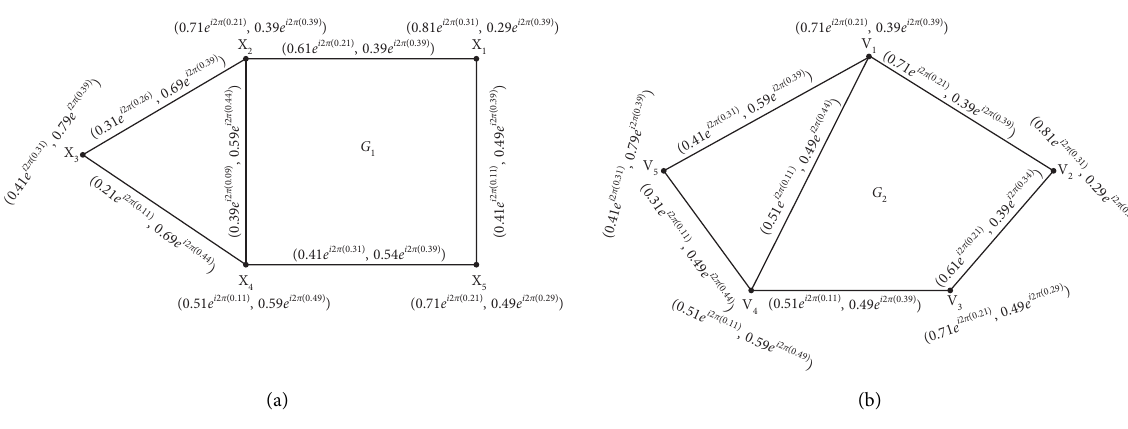
Figure 8: The two graphs shown are weak